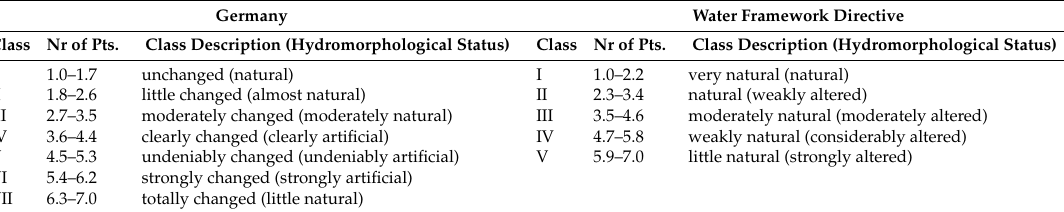
Table 2. Classification of the hydromorphological status according to LAWA (Germany and WFD). Germany Water Framework Directive Class Nr of Pts.